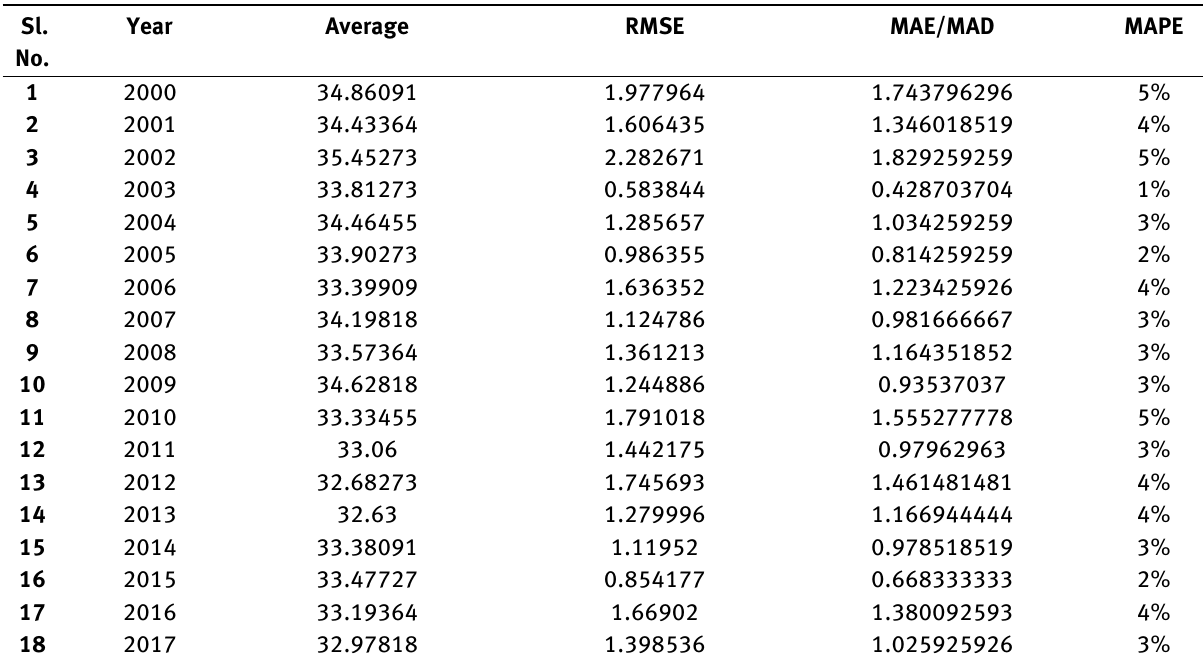
Table 5: Statistical Analysis of Temperature Histogram over 18 Years. Sl.